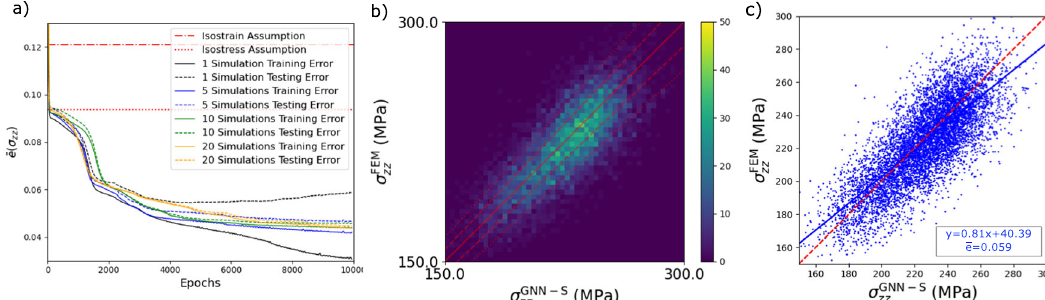
Fig. 8 Results of a GNN model for LSHR grain-scale elastic response generated with a single tessellation and “ shuf fl ed ” orientation sets using the lattice orientation (components of the Rodrigues vector r ) as nodal features. a Learning rates using various numbers of CEFEM simulations for training and testing. b Histogram and c scatter plot of the grain-scale stress predictions on a new microstructure comparing those from a GNN trained with data from the shuf fl ed orientation sets in a single tessellation (GNN-S) and full- fi eld